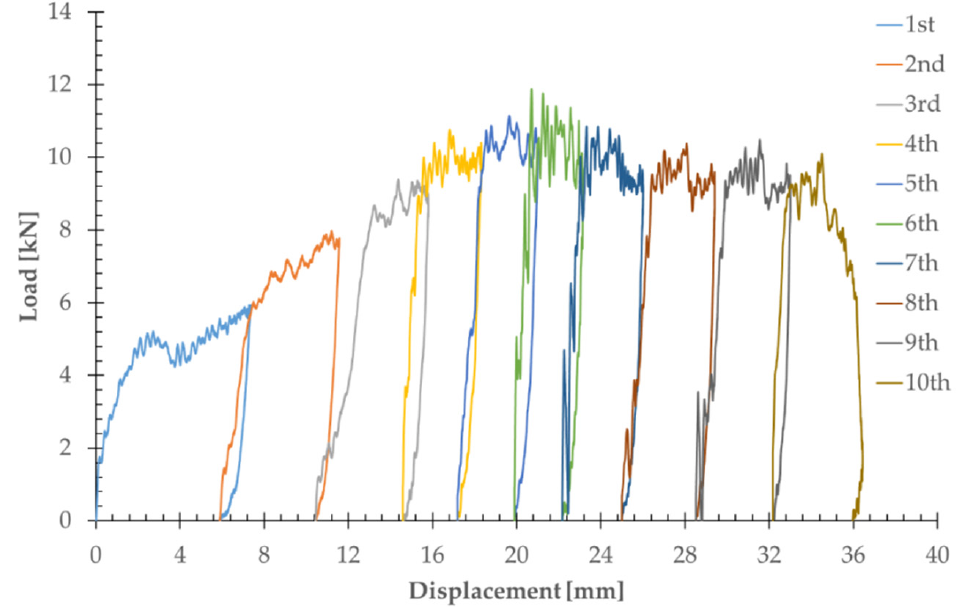
Figure 11. Experimental curves for AFS panel subjected to repeated impacts at impact energy equal to 35 J [6].